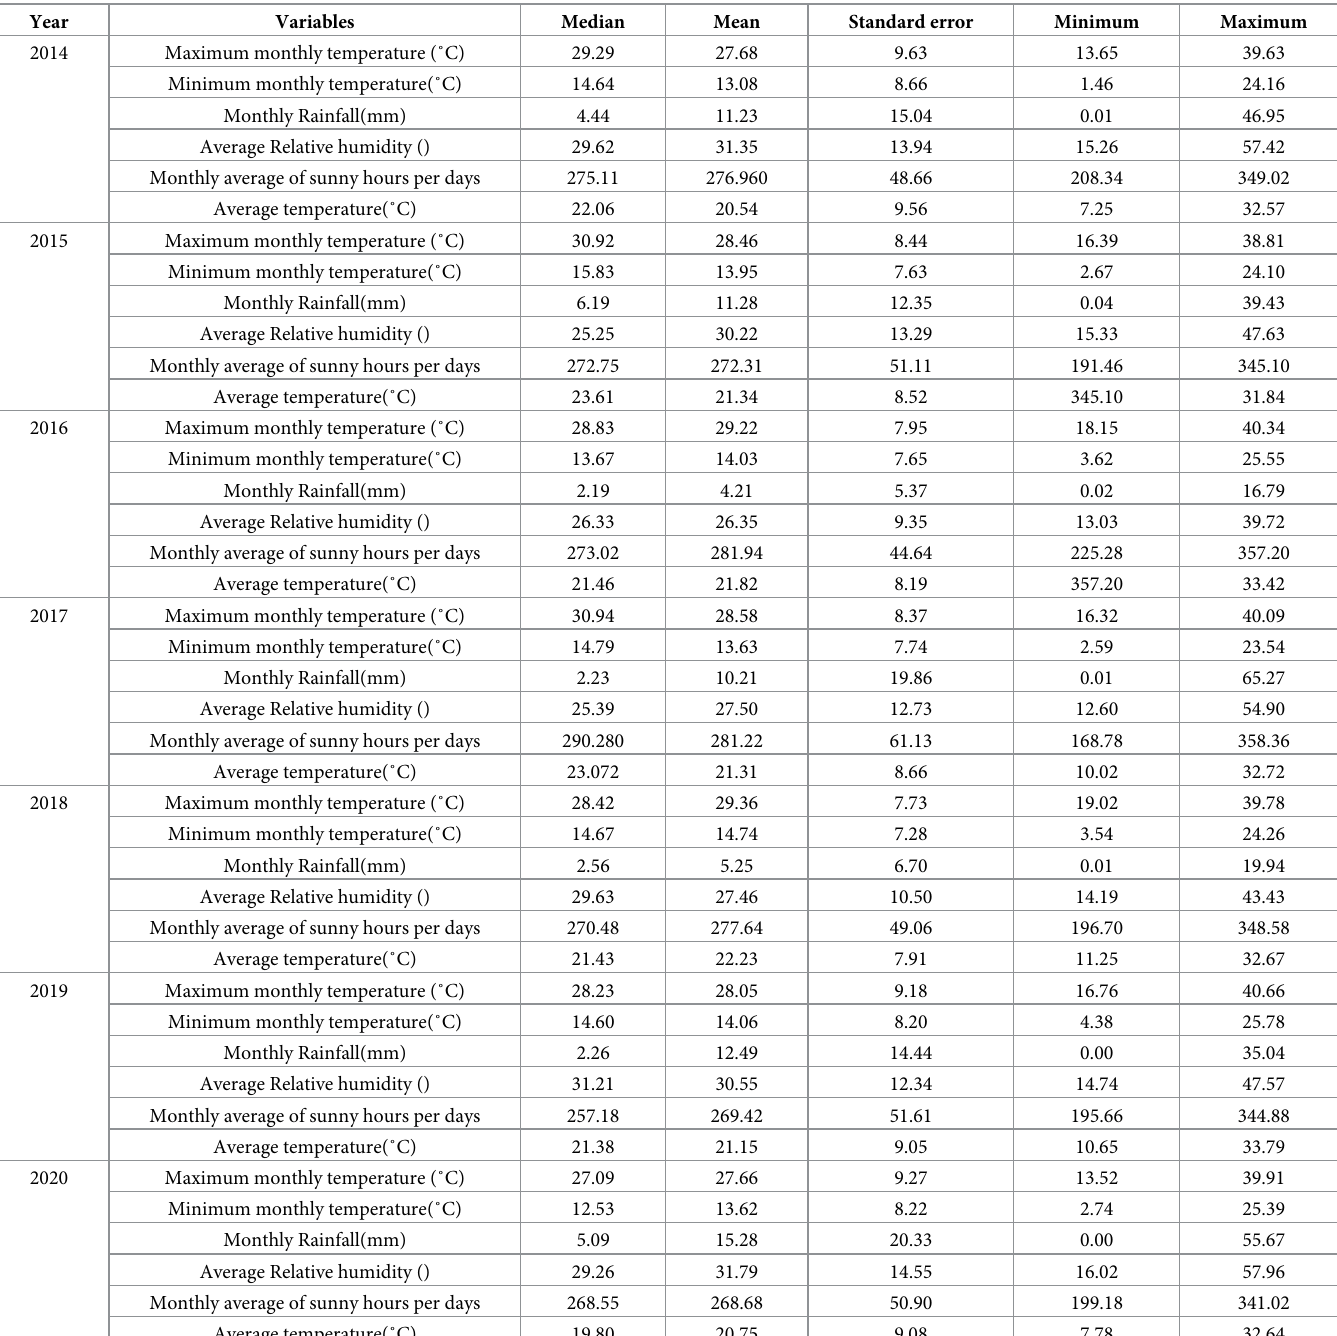
Table 1. Descriptive characteristics of meteorological variables in Kerman province, Iran during